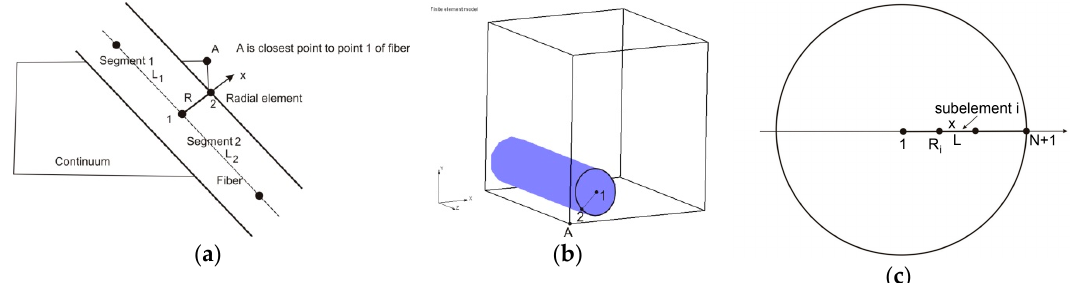
Figure 3. Definition of 1D radial finite element ( a ) and ( b ), and 1D radial element with subelements ( c ), according to Reference [22]. Copyright 2017. Reproduced with permission from the Journal of the Serbian Society for Computational Mechanics.